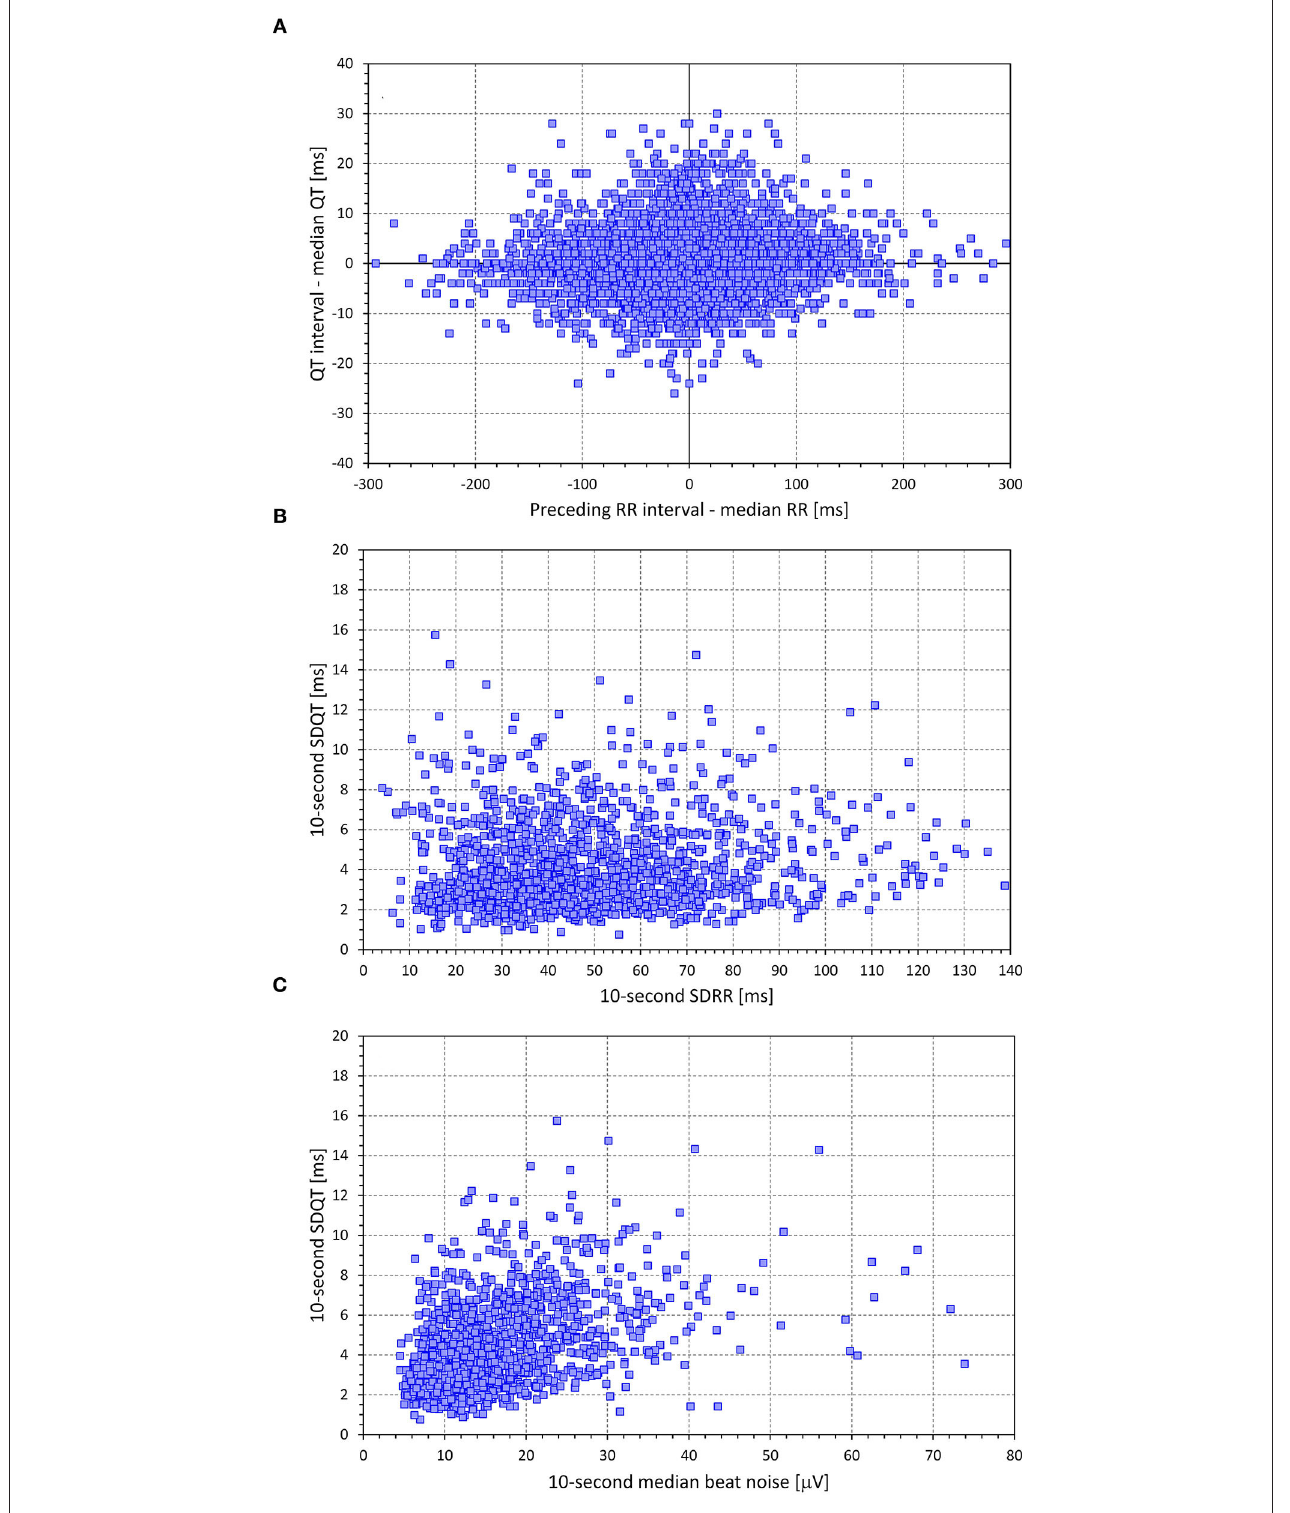
FIGURE 2 | Example of data distribution in a 34-year-old male. The layout of the figure is the same as in Figure 1 .